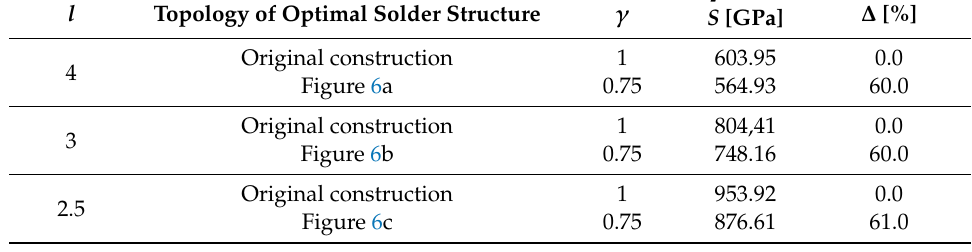
Table 2. Results of topological optimization for the non-symmetric package.